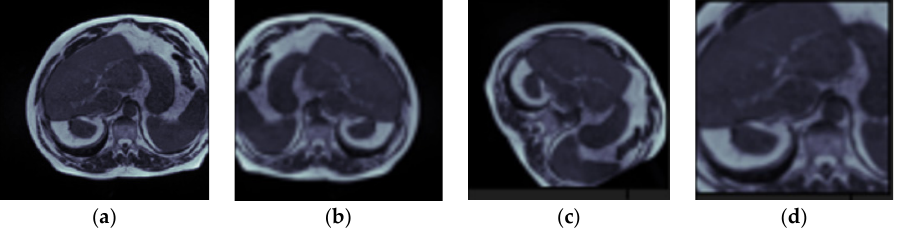
Figure 6. Data Augmentation: ( a ) Input Image, ( b ) Horizontal Flip, ( c ) Rotation & ( d ) Zoom.